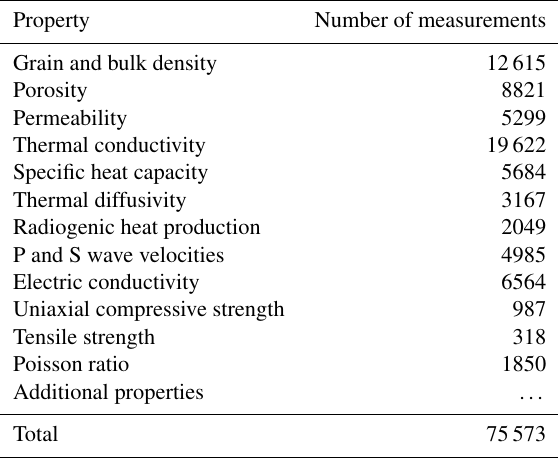
Table 4. Number of measurements of the different properties in P 3 .